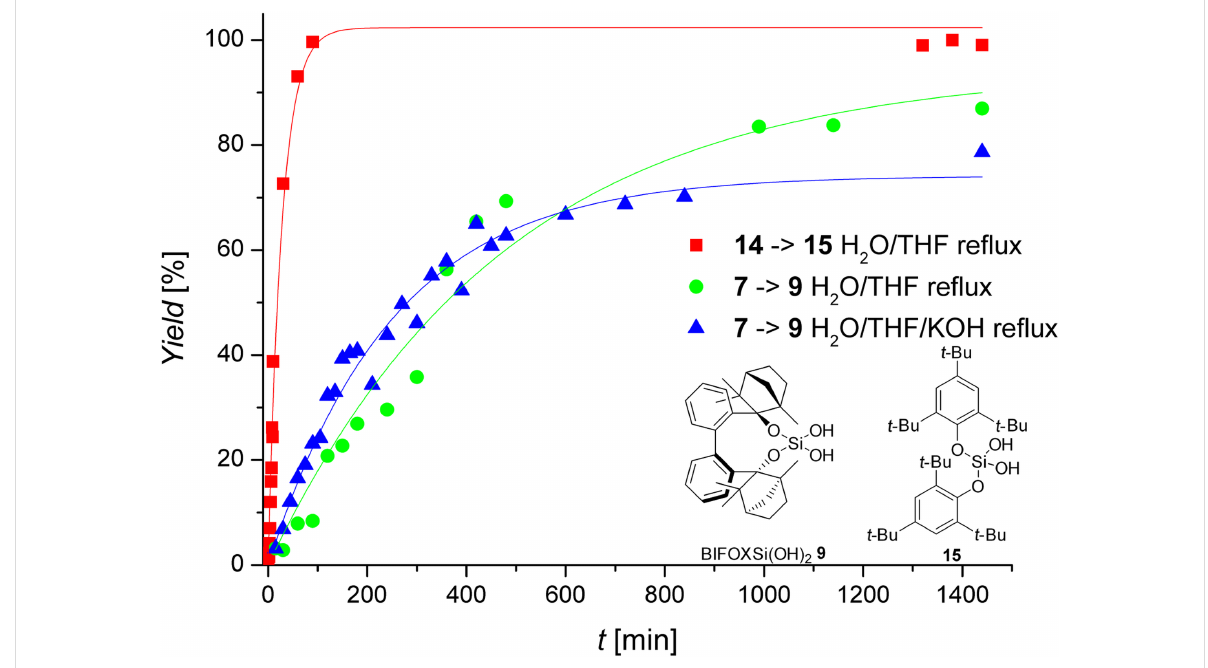
Figure 2: Hydrolyses of dichlorosilane 7 and 14 to BIFOXSi(OH) 2 ( 9 , green circle) and bis(2,4,6-tri- tert- butylphenoxy)silanediol ( 15 , red square) in H 2 O/THF reflux and BIFOXSi(OH) 2 ( 9 , blue triangle) in H 2 O/THF/KOH reflux conditions. Isolated yields are plotted against reaction time (Table 1, Scheme 3 and Scheme 4). Reflux conditions are: H 2 O/THF ≈ 77 °C, H 2 O/THF/KOH ≈ 80 °C.